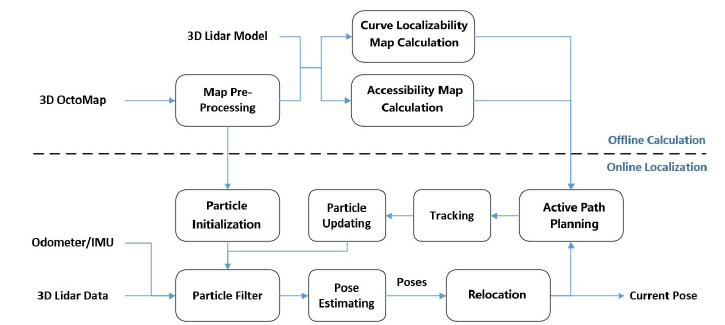
Figure 1. Framework of Curve-Localizability-Based Active Localization